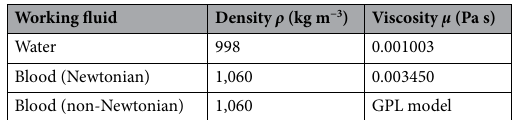
Table 2. Working fluids modeled and physical